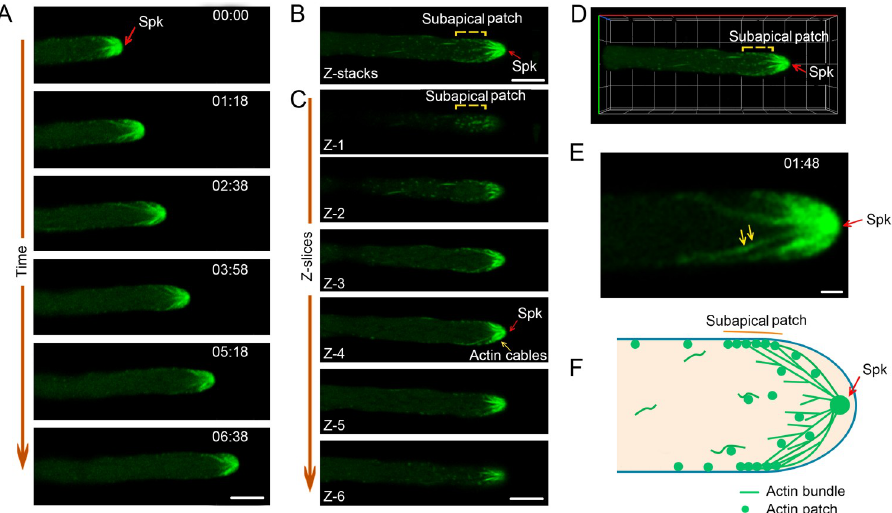
Fig 2. Organization of the actin cytoskeleton at the growing hyphal tip. (A) Time-lapse images illustrating actin distribution in the tip region of a growing hypha in liquid CM. The corresponding movie is provided as S1 Movie, which contains 200 frames. The numbers at the top right corner indicate the timestamps (min:s). Bar = 5 μ m. (B) Maximum projection of Z-slices obtained by imaging a hyphal tip illustrating the structure of the actin cytoskeleton. Bar = 5 μ m. (C) Z-slice images of (B) showing the distribution of subapical actin patches, actin cables, and actin at the Spk in an active hypha. (D) 3D image obtained from photographs in (B) and (C) showing the spatial structure of the actin cytoskeleton in the hyphal tip. The corresponding movie is provided as S2 Movie. (E) Time-lapse images (10 time points) showing the dynamic transport of patches along the actin bundle. The red arrows indicate the actin patches. The corresponding movie is provided as S3 Movie. Bar = 2 μ m. (F) A proposed model showing the bowl-shaped organization of the actin cytoskeleton in the hyphal tip.